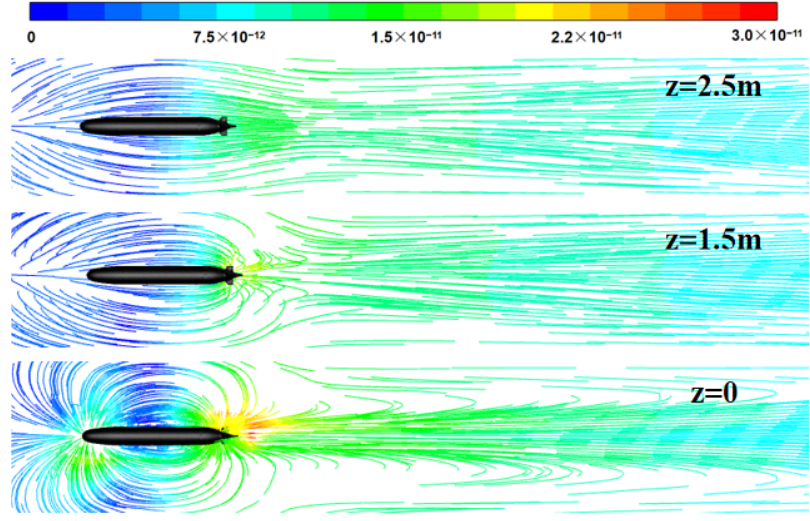
Figure 7. Cross sections of the wake magnetic field at different altitudes for 10 s of submarine movement.